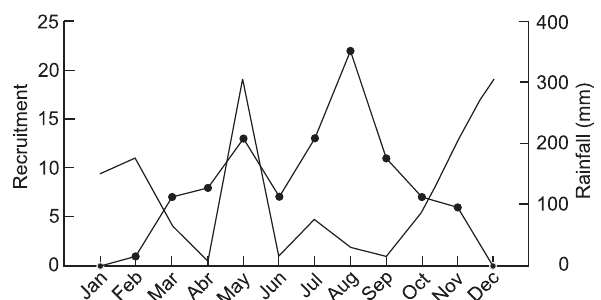
Figure 9. Recruitment pattern of H. marginatus and rainfall during the study period: (  ) Recruitment, and (–)